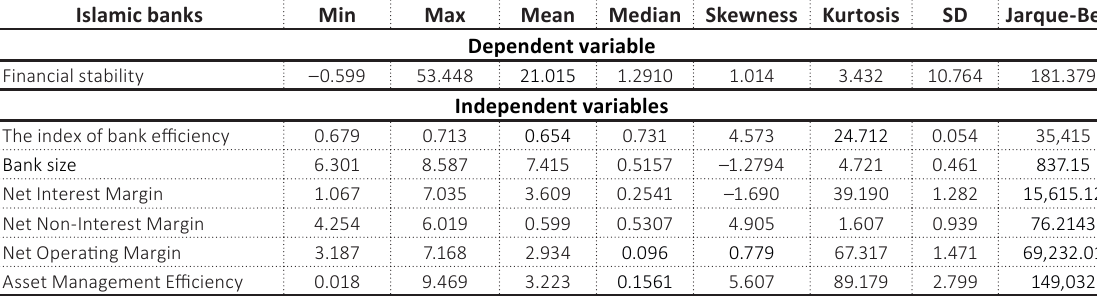
Table 6. Descriptive statistics for Model B